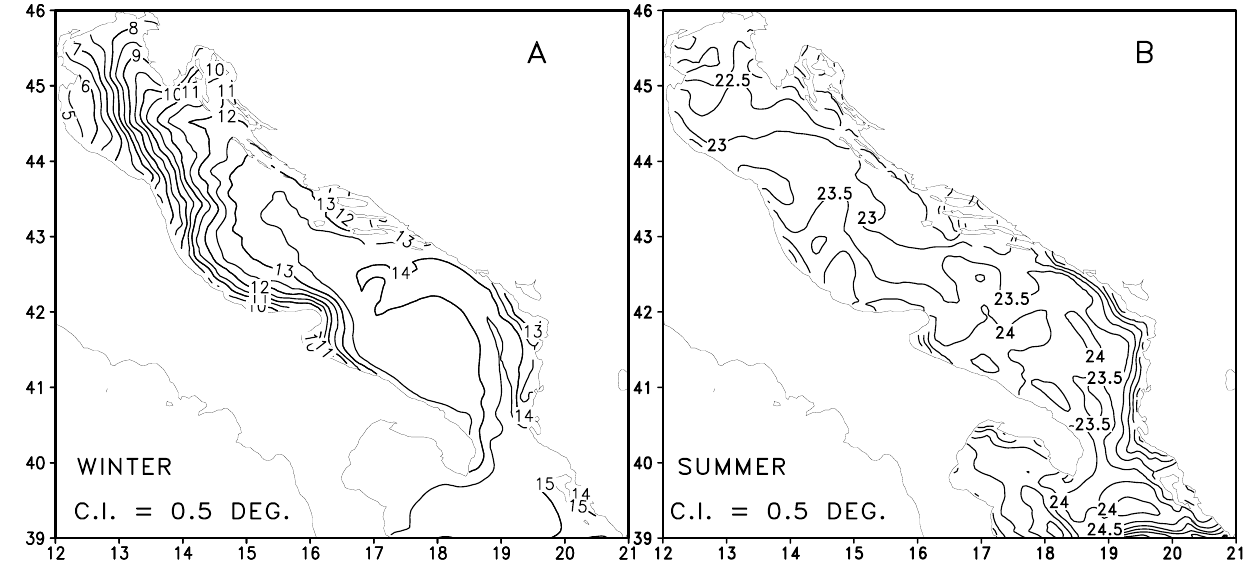
Fig. 6. Adriatic Intermediate Model (AIM). Seasonal surface temperature fields. (A) : winter, (B) : summer. Contour interval is 0.5 ◦ . Seasons definition as in Artegiani et al. (1997a,